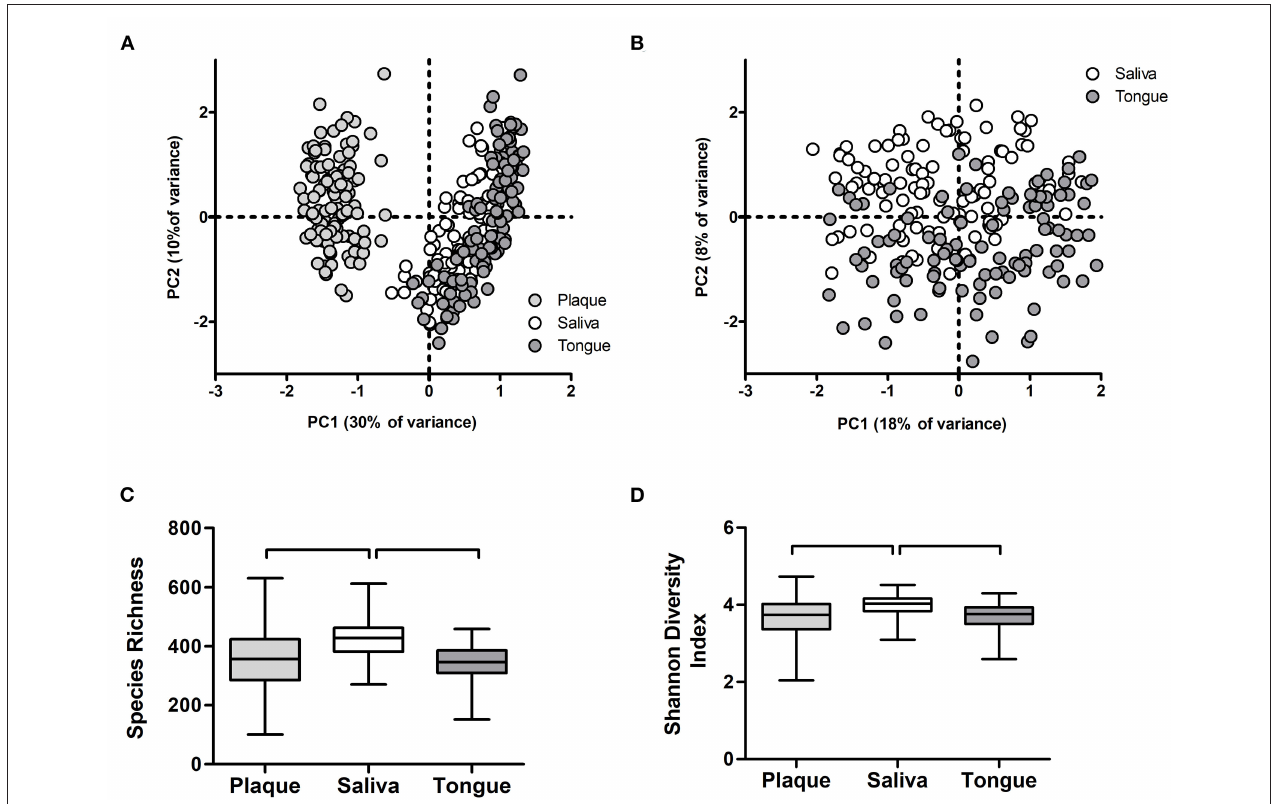
FIGURE 8 | Microbiome output of the baseline samples: (A) Principal Component Analysis (PCA) of plaque, salivary, and tongue samples; (B) PCA of salivary and tongue samples; (C) species richness (zOTUs/sample) and (D) Shannon Diversity Index per sample type. Connectors indicate statistically significant differences ( p < 0.05, Wilcoxon Signed Ranks